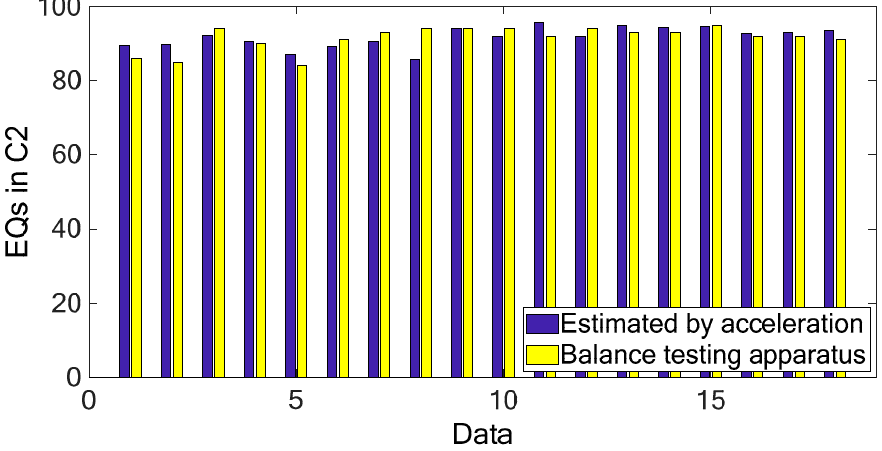
Figure 15. Estimated EQs values compared with EQs values of commercial computer-aid balance testing apparatus in